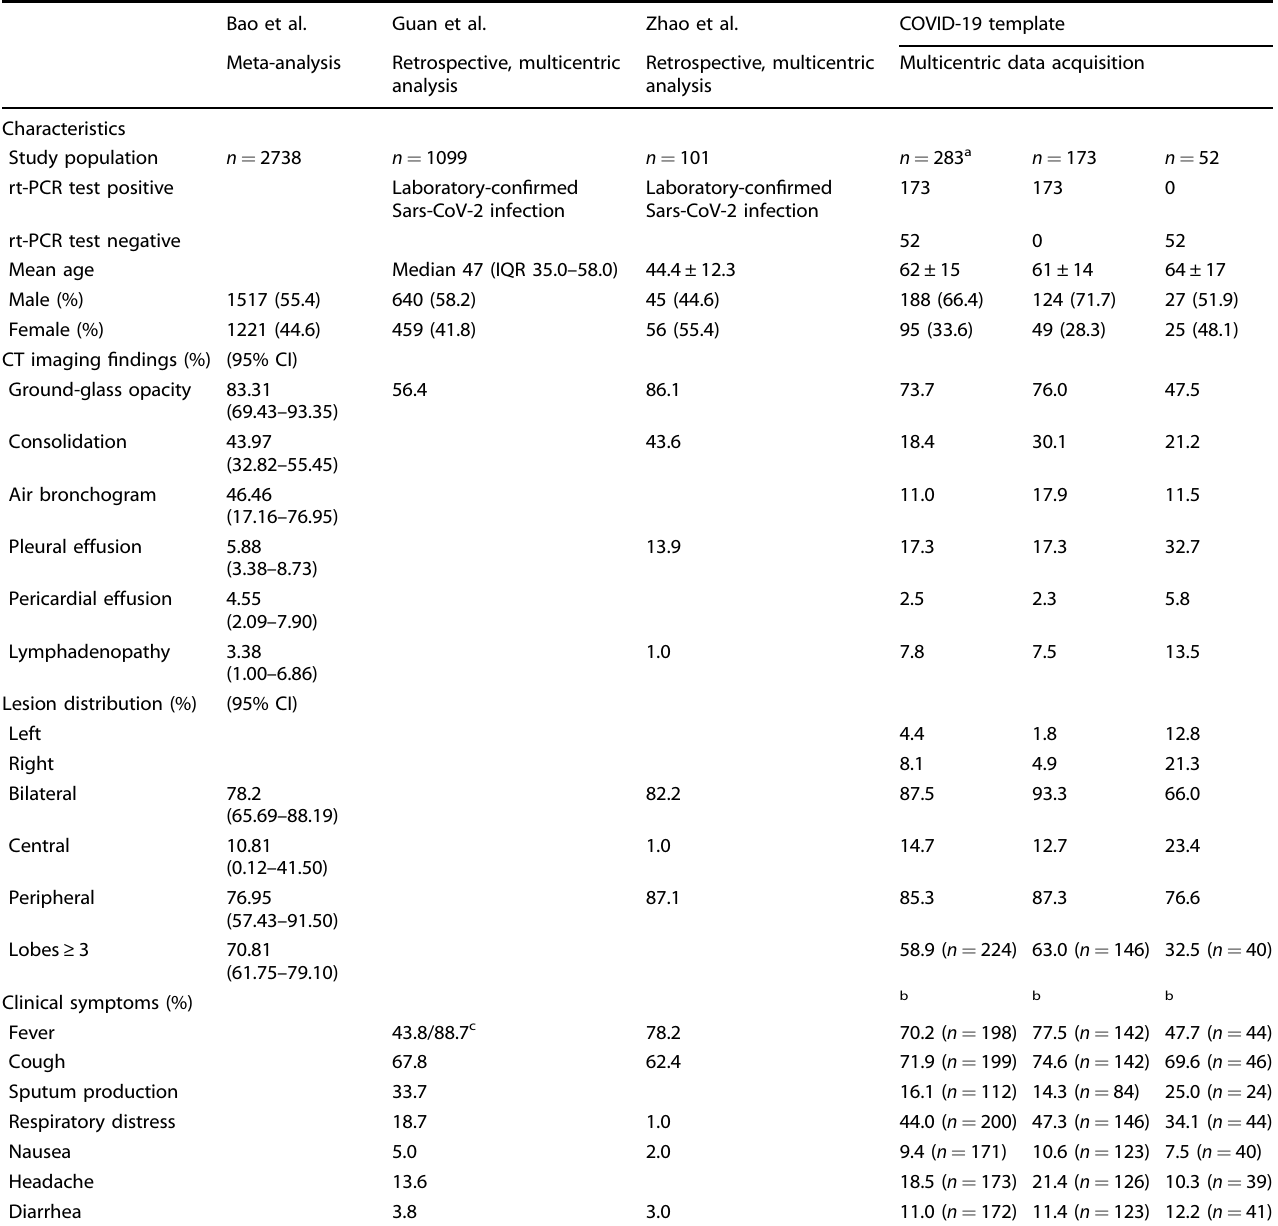
Table 1. Comparison of aggregated data from an ad hoc usage analysis using the COVID-19 template recommendation and proposed software platform with key research fi